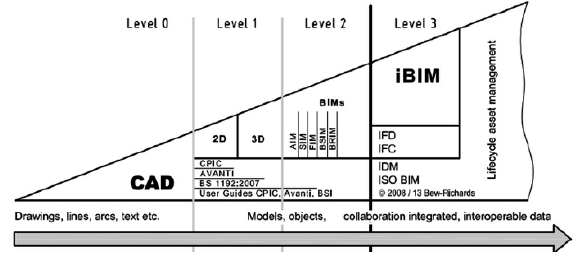
Figure 04 . BIM maturity scheme (Bew, Richards, 2008). The same scheme is applicable to the development of the science of architectural survey as well as to the design of new